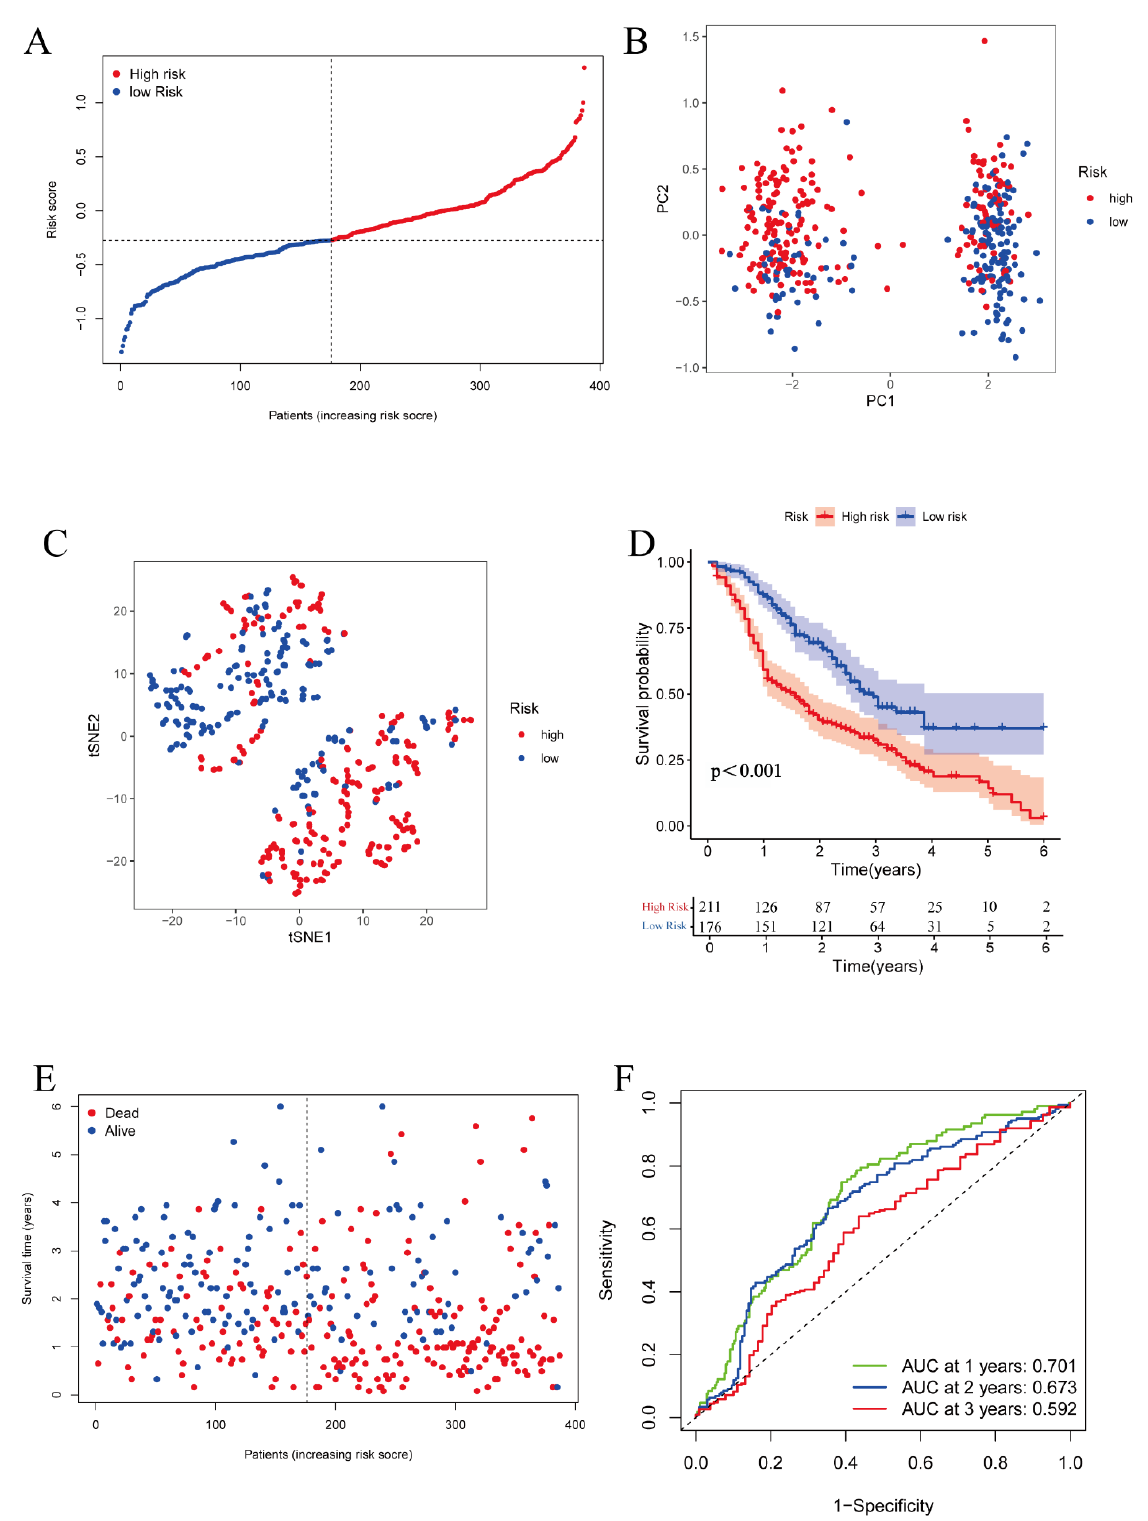
Figure 5. Validation of the prognostic signature in the GEO cohort. ( A ) Distribution of the risk score in the GEO cohort. ( B ) PCA plot of the GEO cohort by 5 genes. ( C ) t-SNE analysis in the GEO cohort by 5 genes. ( D ) Kaplan–Meier survival curve for OS of ovarian cancer in the GEO cohort. ( E ) Distribution of survival status and risk score of each patient. ( F ) ROC curve demonstrating the predictive efficiency of the 5-gene prognostic signature in the GEO cohort.